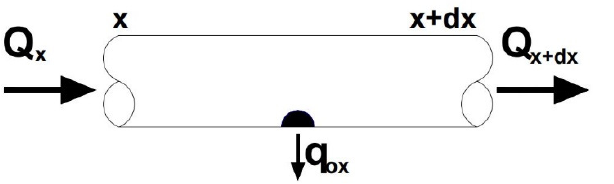
Figure 1. Elemental section of a drip lateral having length dx and with one emitter.